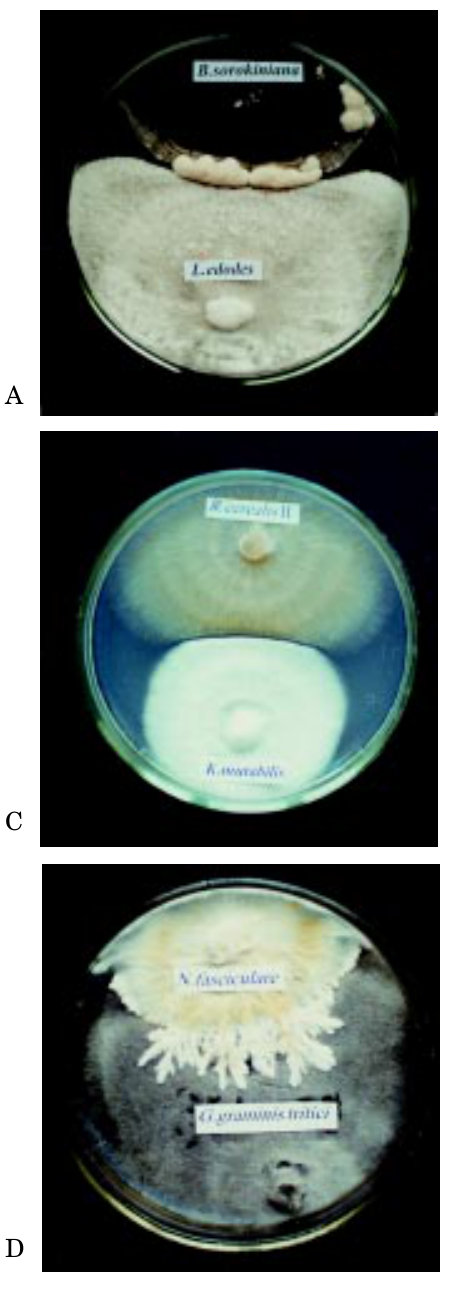
Fig. 1. Combative interactions between xylotrophic mushrooms and phytopathogenic fungi in dual cultures on pota- to dextrose agar. (A) Deadlock with mycelial contact between L. edodes and B. sorokiniana 20 days after inoculation. (B) Deadlock at a distance between H. sublateritium and R. cerealis 10 days after inoculation. (C) Initial deadlock between K. mutabilis and R. cerealis 7 days after inoculation, followed by replacement (D) of the pathogenic fungus by dense mycelial waves of K. mutabilis 7 days later. (E) Replacement of G. graminis var. tritici by mycelial cords of H. fasciculare 21 days after inoculation. (F) Replacement of B. sorokiniana by L. tigrinus 30 days after inoculation. Note the presence of fruiting body primordia of L. tigrinus in the interaction